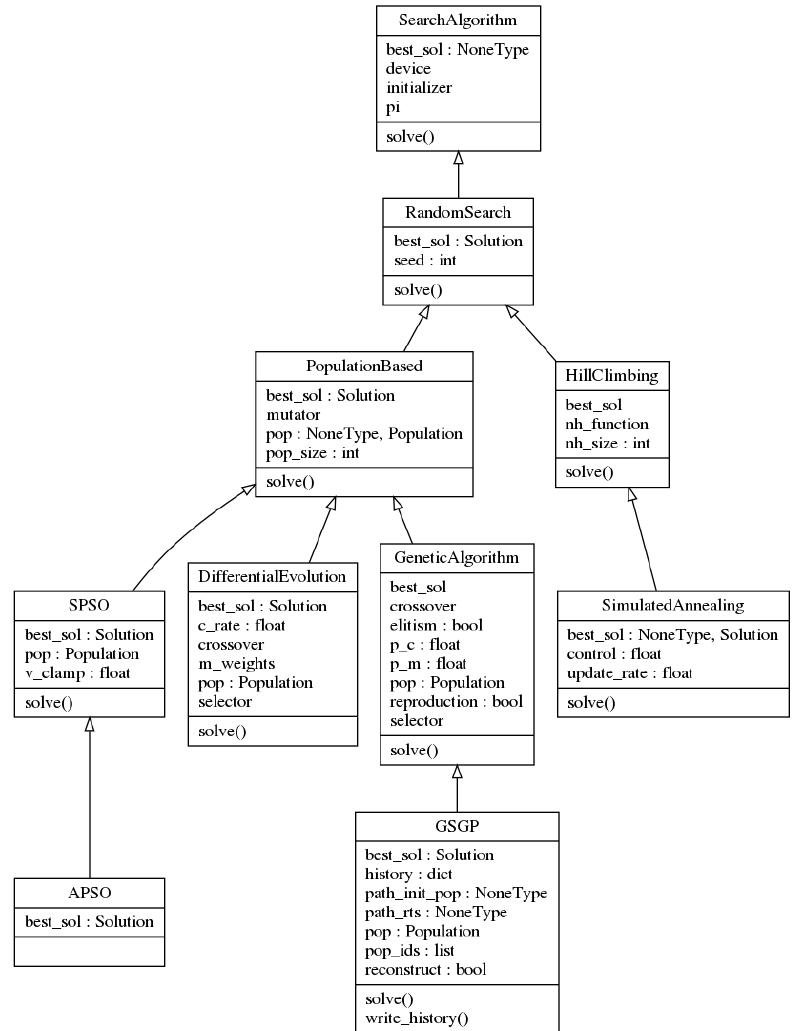
Figure 2. UML diagram of the algorithm class SearchAlgorithm and relative subclasses, as imple- mented in